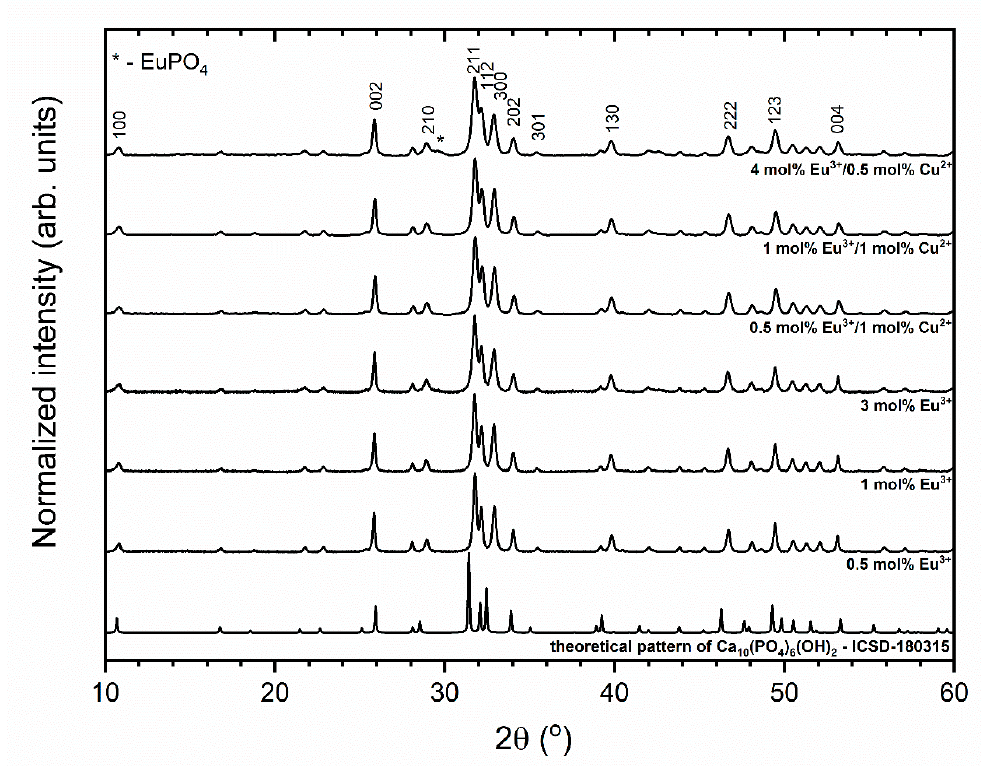
Figure 1. X-ray powder diffraction patterns of the Eu 3+ -doped and Eu 3+ /Cu 2+ co-doped Ca 10 (PO 4 ) 6 (OH) 2 .